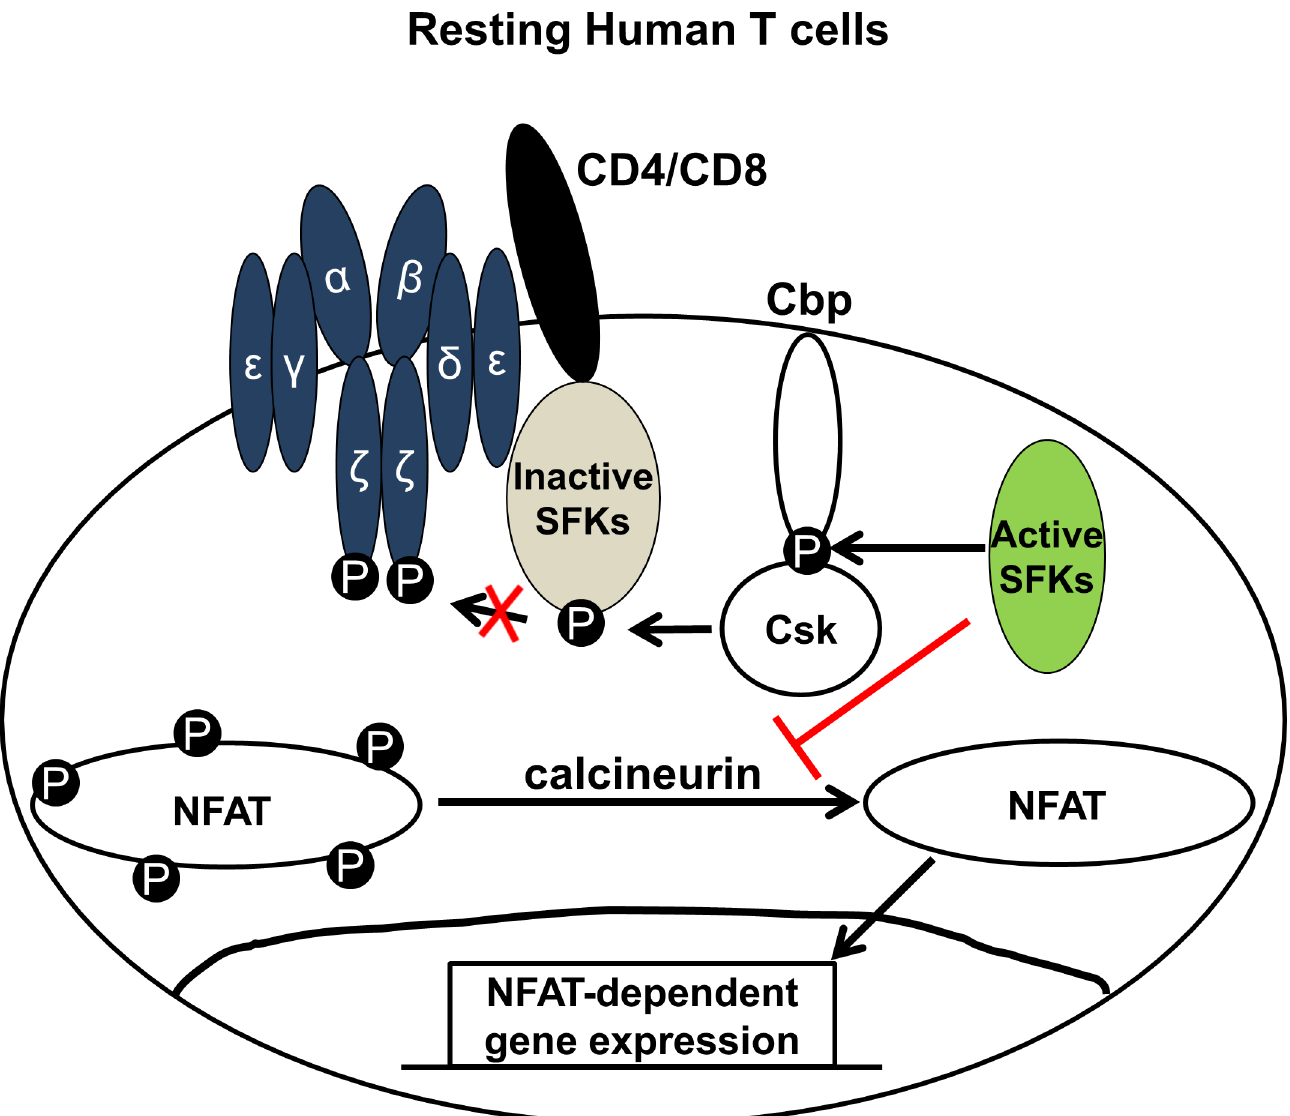
Fig 8. Proposed model for the role of active SFKs in resting human T cells. In resting humanT cells, a pool of active Src-family kinases(SFKs) phosphorylates the Csk-bindingprotein (Cbp). Csk bound to the phosphorylated Cbp phosphorylates the majority of SFKs at the inhibitoryC-terminal tyrosine. SFKs phosphorylated at the C-terminal inhibitorytyrosine are enzymatically inactive and cannot mediate proximalT cell receptor (TCR) signalingin absenceof TCR stimulation.In addition,this active pool of SFKs also prevents aberrantNFAT1 activationand negativelyregulates NFAT1-mediated distal TCR signaling in resting humanT cells by suppressing calcineurinactivity. Together, negativeregulationof both proximaland distal TCR signalingby active SFKs contribute to maintainT cells in a quiescentstate in absenceof TCR stimulation.